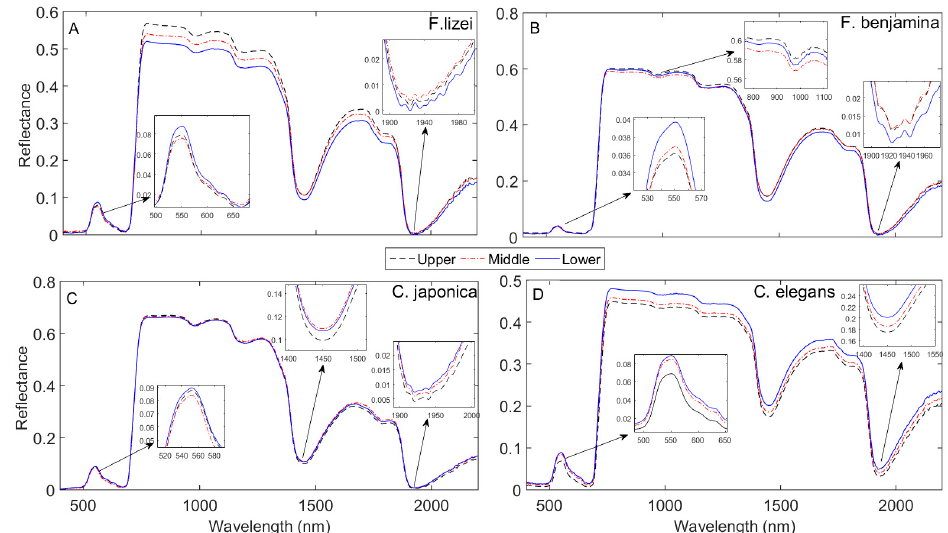
Figure 4. Species-specific mean leaf spectral reflectance at each canopy position for F. lizei ( A ), F. benjamina ( B ), C. japonica ( C ) and C. elegans ( D ).